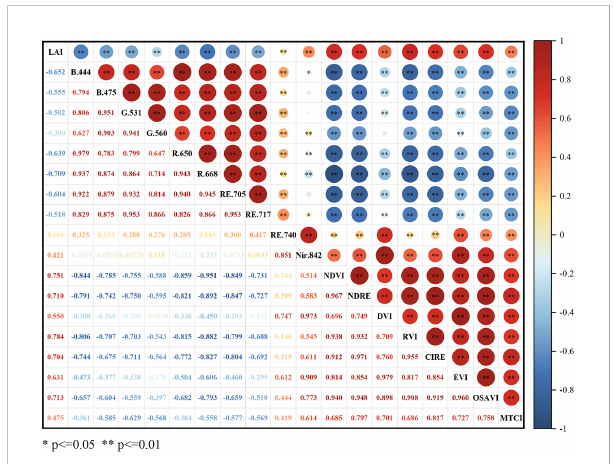
FIGURE 3 Correlation coef fi cient between speci fi c parameters and maize LAI. * and * * are signi fi cant at 0.05 and 0.01 levels, respectively. The red area indicates positive correlation, the blue area indicates negative correlation. Darker colors and larger circles mean a stronger correlation between LAI and spectral